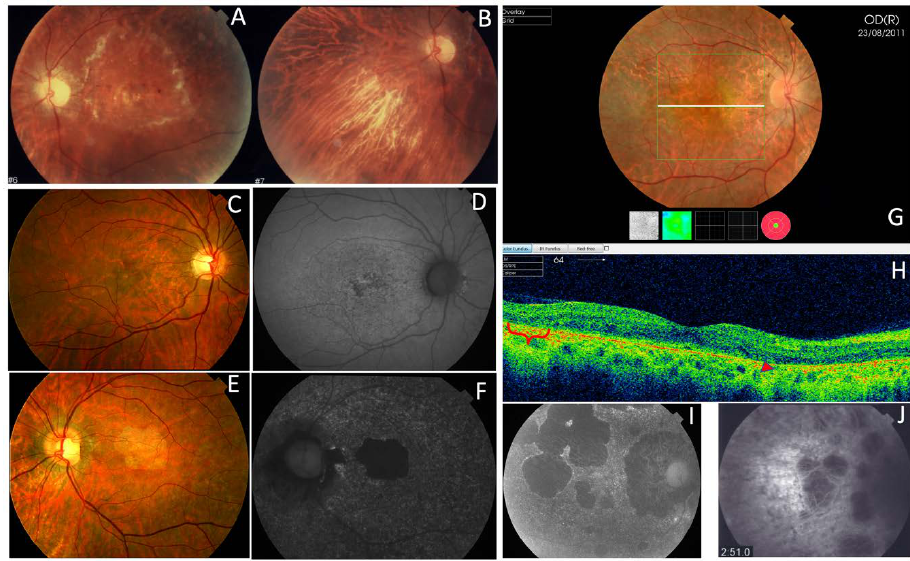
Figure 13. The clinical appearance of family 5b (p.Arg195Leu). F5b-III-4 had ( A ) a large area of atrophy in the posterior pole and ( B ) extensive atrophy in the mid-periphery. The least affected patient was F5b-IV-2 with mild macular changes in the ( C ) fundus and ( D ) AF. F5b-IV-1 had clear macular atrophy in ( E ) the fundus and ( F ) AF. ( G ) F5b-IV-4 had atrophy in the posterior pole and mid-periphery, outer retinal atrophy (red brace and red arrow) was much more evident in the ( H ) SD-OCT and ( I ) autofluorescence images, and ( J ) extension of atrophy to the mid-periphery was evident in the fluorescein angiogram.